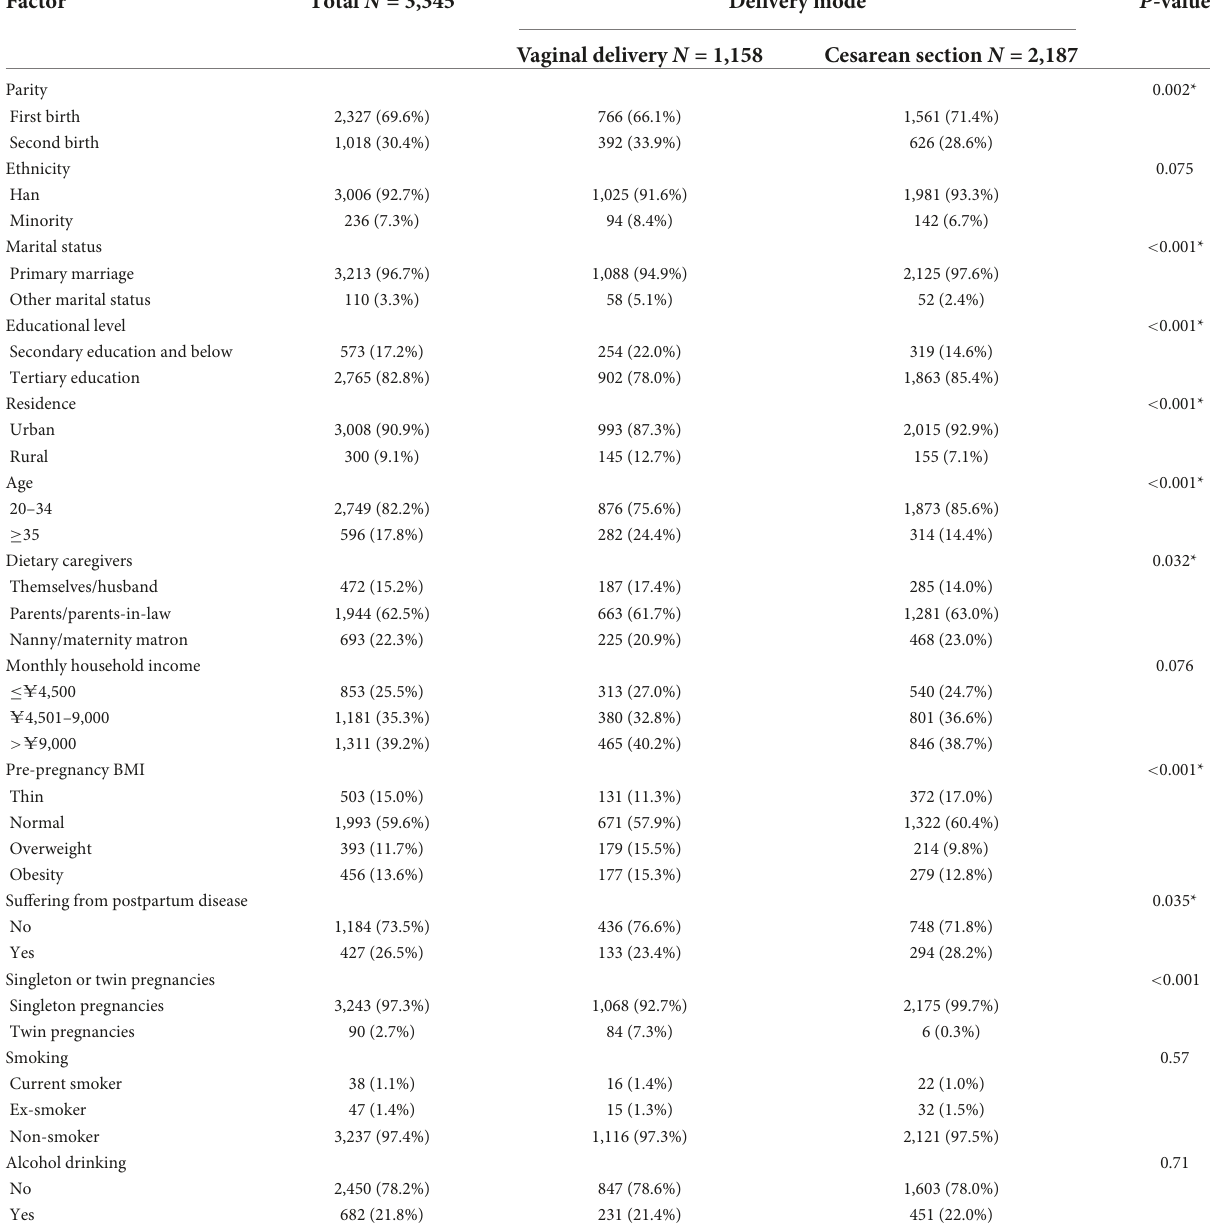
TABLE 2 Basic demographic